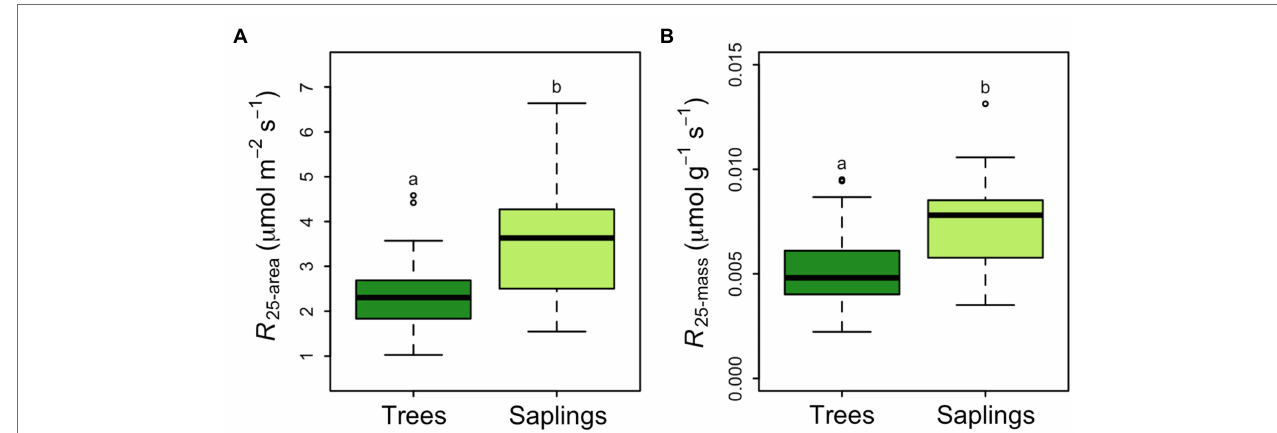
FIGURE 4 | Picea glauca leaf respiration normalized to 25 ° C, as a function of tree size at the FTE in Alaska. Respiration is expressed as a function of leaf area (A) and leaf mass (B) . Boxplots represent the median and the first and third quartiles. Whiskers delimit the range for each group, with outliers falling outside 1.5 times the interquartile range marked by points. Significant differences between groups are marked by different letters ( p < 0.05). Dark green boxes = trees ≥ 10 cm DBH, light green boxes = saplings 5–10 cm DBH. n =